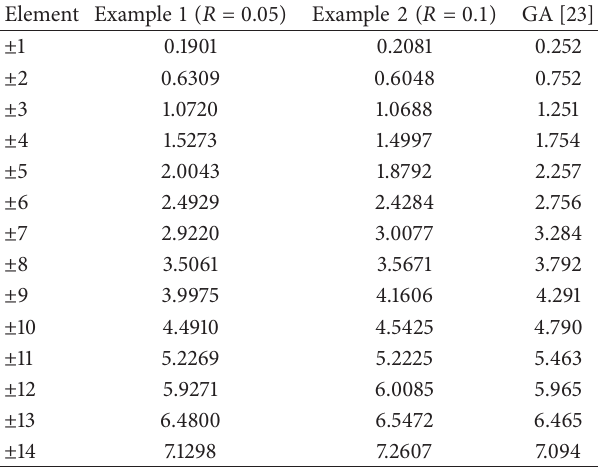
Figure 3: The convergence characteristics of side lobe level for optimization of a 28-element linear array. Table 1: Element position of the 28-element linear array (normal- ized with respect to 𝜆 ).